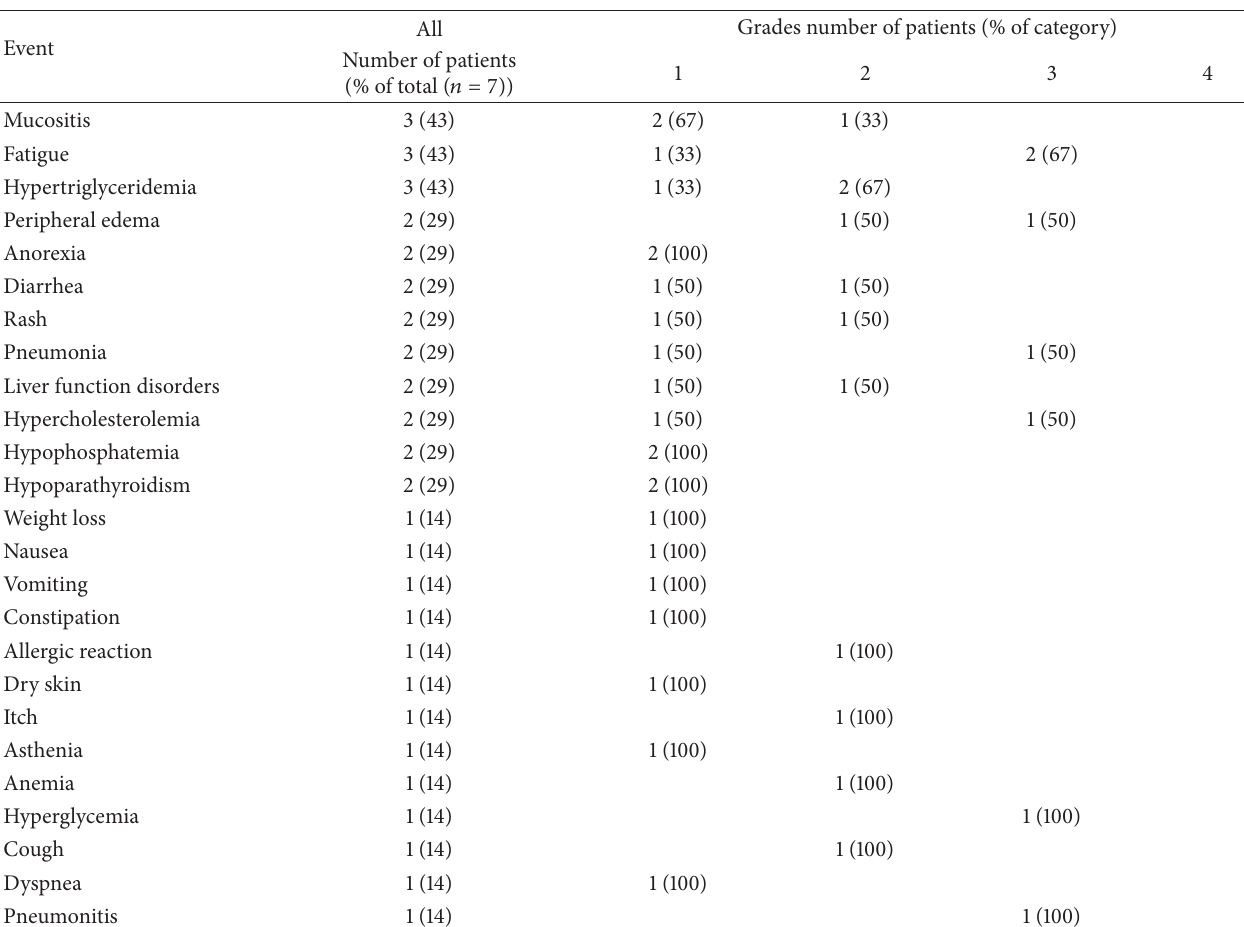
Table 4: Adverse